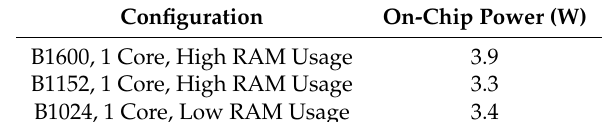
Table 9. On-chip Power Consumption Estimates on Vivado IDE.